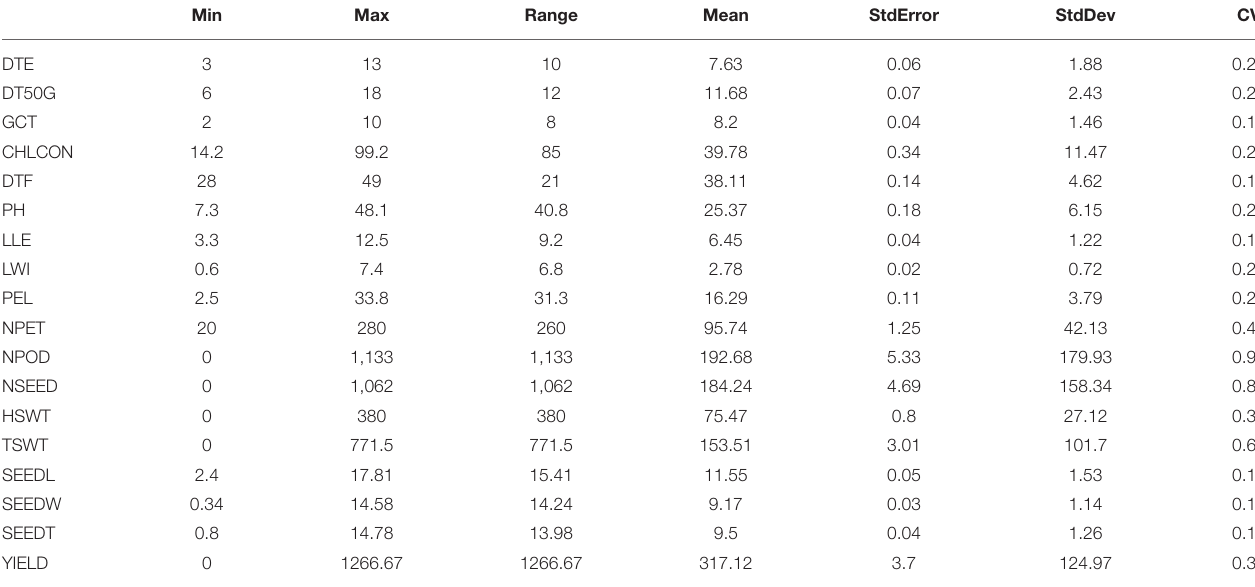
TABLE 4 | Summary statistics of the traits